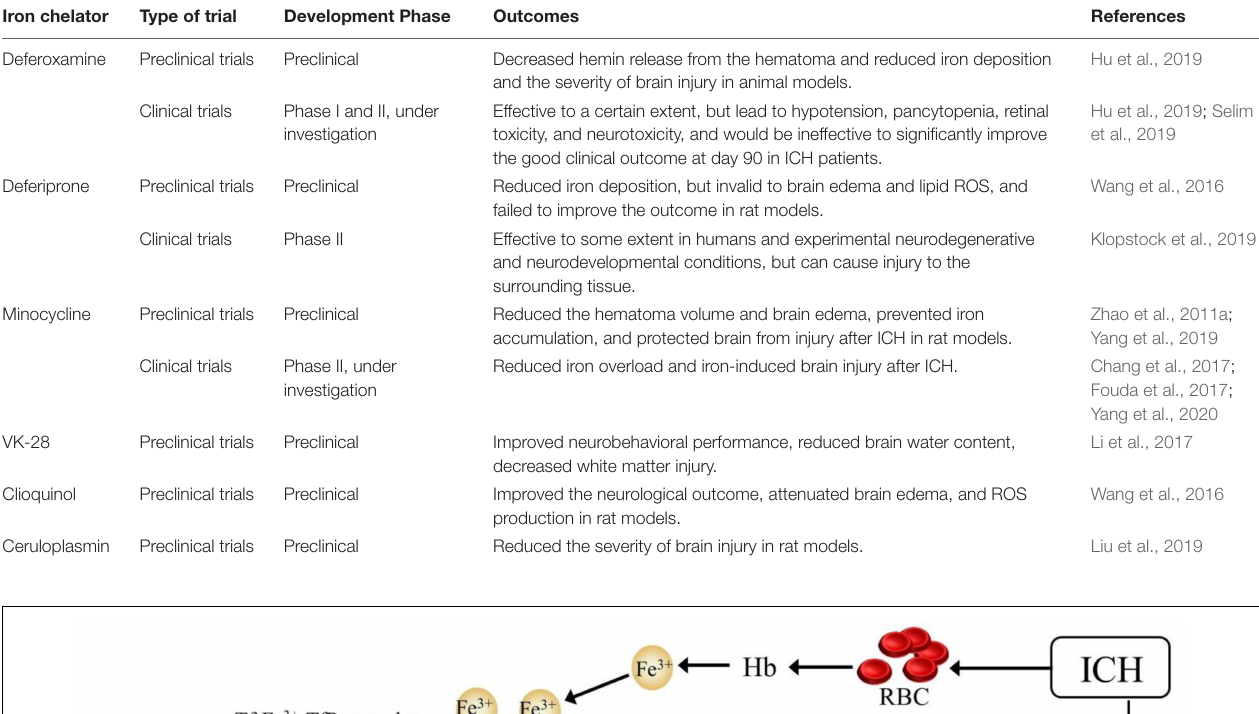
TABLE 3 | Outcomes of some major iron chelators used in ICH in the clinical and preclinical studies.